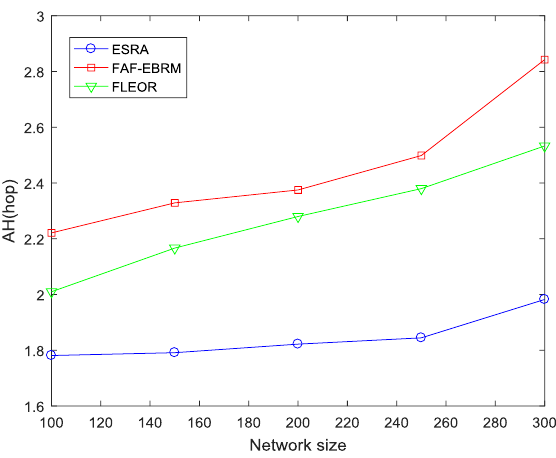
Figure 7. The AH comparisons with varying network size.